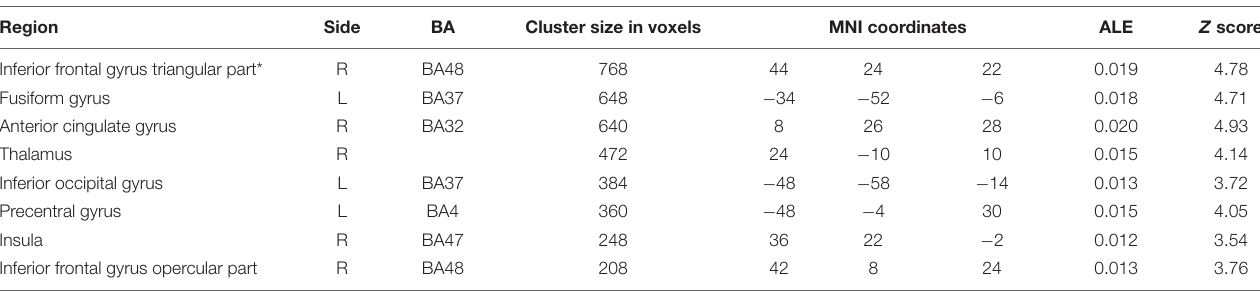
FIGURE 4 | Unconscious priming effect. Incongruent activation was greater than congruent and neutral activation. Spheres with a radius of 5 mm are visualized to present the statistical results of clusters formed. Red spheres represent results that survived FWE correction, while yellow spheres represent results that are uncorrected. IFGtriang, inferior frontal gyrus triangular part; FFG, fusiform gyrus; ACG, anterior cingulate gyrus; THA, thalamus; IOG, inferior occipital gyrus; PreCG, precentral gyrus; INS, insular; ORBinf, inferior frontal gyrus opercular part; L, left; R, right. TABLE 3 | Incongruent activation greater than neutral and congruent